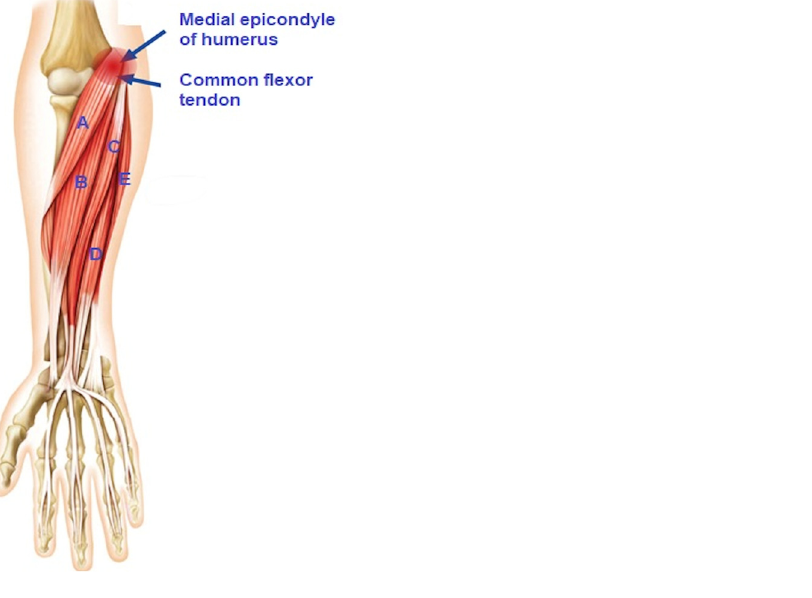
Figure 1. Muscles of the elbow and their attachment of medial epicondyle of humerus. Figure depicting elbow’s muscle attachment. The letters represent: A—pronator teres muscle; B—flexor carpi radialis; C—palmaris longus; D—flexor digitatorum superficialis; E—flexor carpi ulnaris.